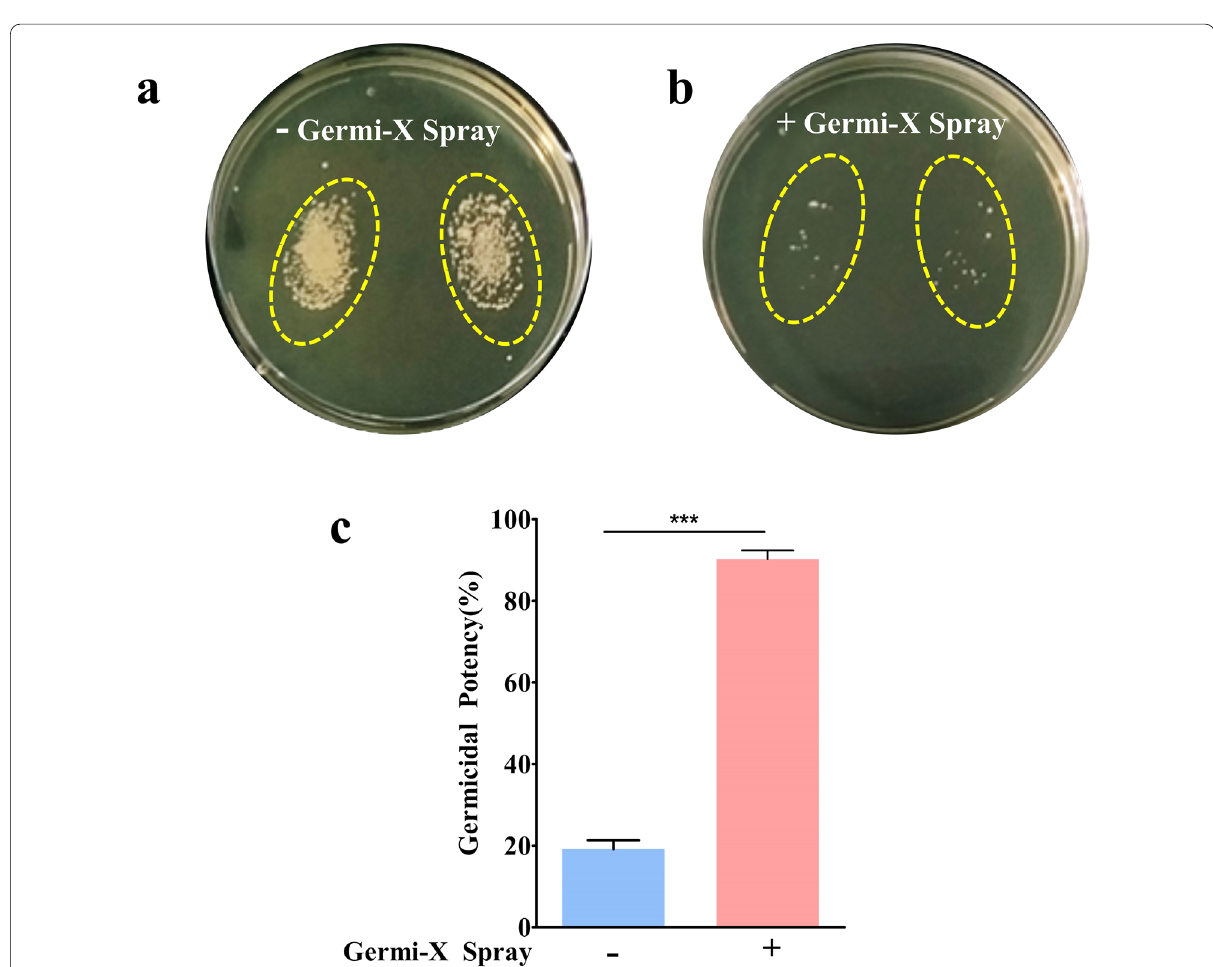
Fig. 4 Sanitizing efficacy of Germi-X spray. a , b Representative digital images of bacteriological plates with thumb prints from the same volunteer without ( a ) and with sanitization ( b ) with Germi-X spray. c Sanitization efficacy of Germi-X spray is represented as % germicidal potency bar graph. Statistical significance was determined through Student’s t-test and observation represented as ***p < 0.001 for the difference between sanitization without and with Germi-X